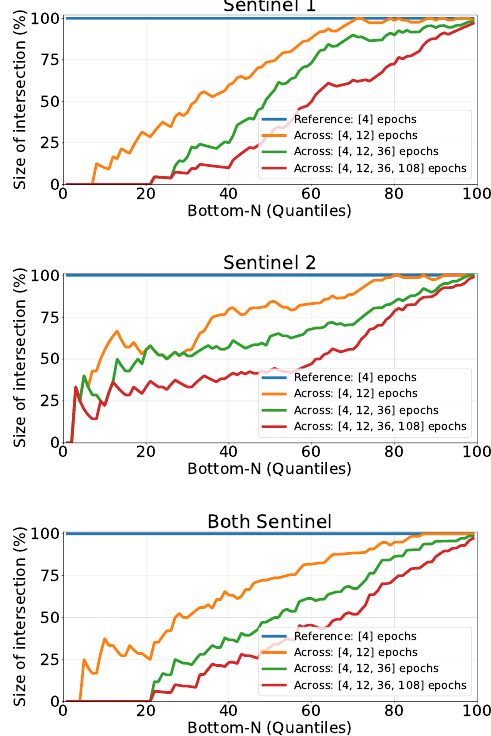
Figure 10. Positive persistence for Sentinel-1, Sentinel-2 and when using both sensors.